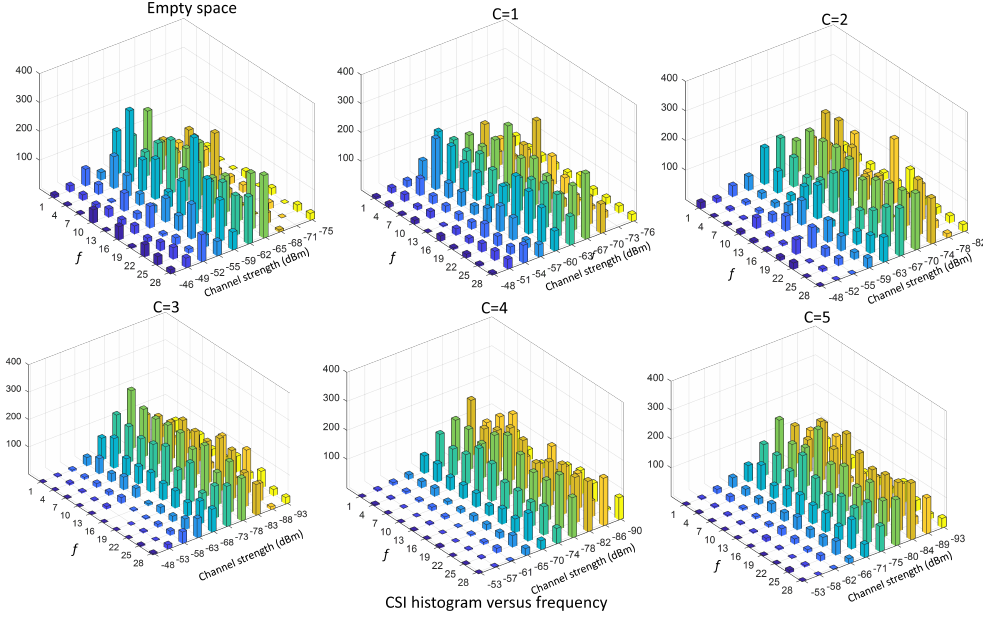
Figure 4. CSI histograms versus frequency p f ( s ) with f = f 1 , . . . , f 30 , for the number of people ranging